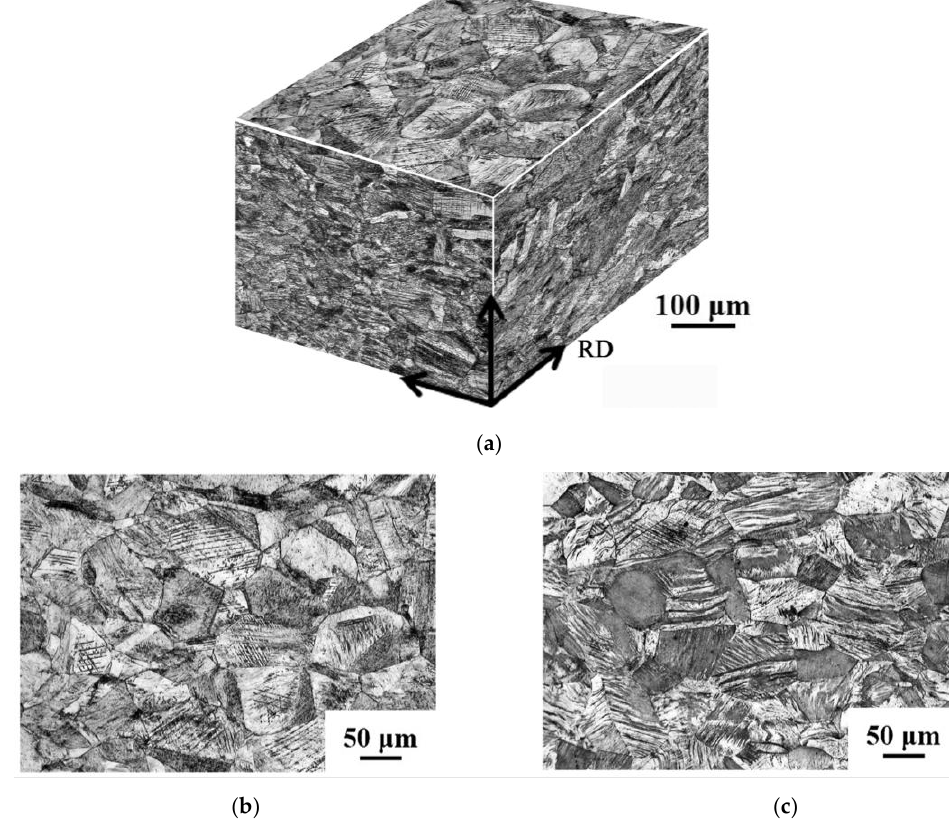
Figure 2. Optical metallographs of: ( a ) three mutually perpendicular planes of the CR, ( b ) CR-300, and ( c ) CR-450 specimens.